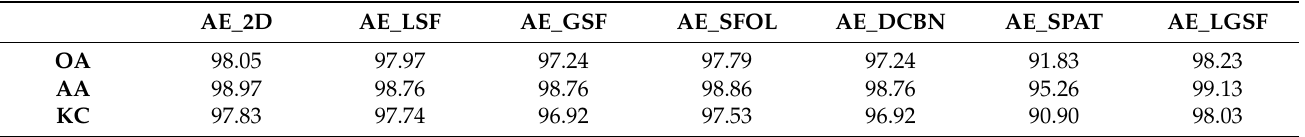
Table 13. Classification results of ablation experiments on the Salinas Valley dataset. (shown in